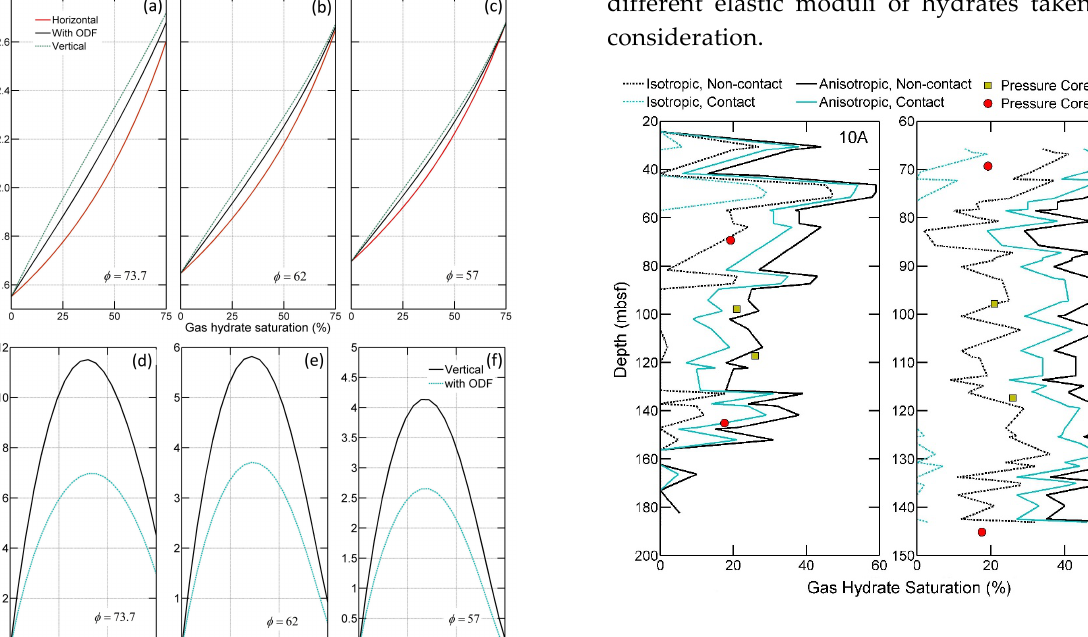
Figure 4. Gas hydrate saturation for well 10A and 10D in case of pore filling morphology. Saturation measured via pressure core also shown for well 10D and 10B (within ~10m distance to 10A) [Collett et al. 2008, Lee and Collett